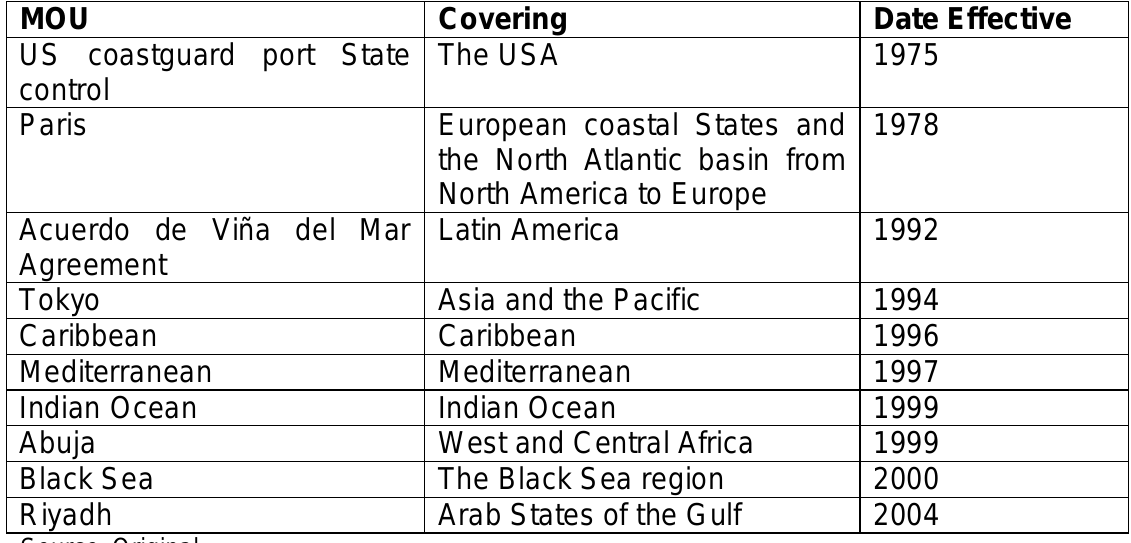
Table 2: Port State Control Regimes 1